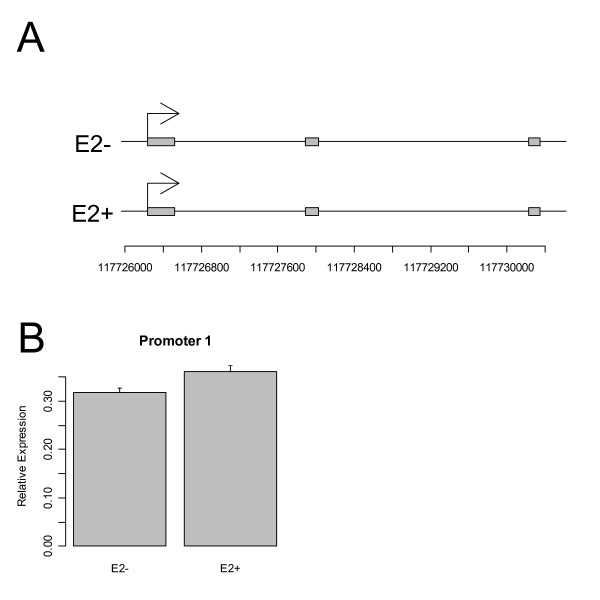
Shown here are the first three exons of the gene EIF3S9, spanning a region of approximately 3.7 kb (A). This promoter was shown to be highly active in both treatments, which was verified by qRT-PCR. Error bars indicate standard errors from the mean for three replicates.